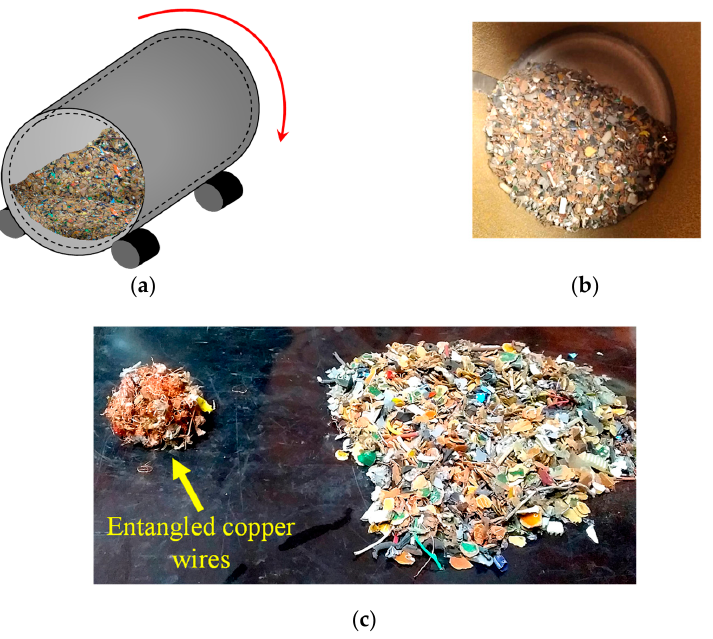
Figure 11. Tests of selective recovery of copper wires by entanglement. ( a ) Concept illustration. ( b ) Samples of comminuted PCBs inside the drum before testing. ( c ) Test outcome for the +5 mm sample, highlighting the formation of a chunk of entangled copper wires.